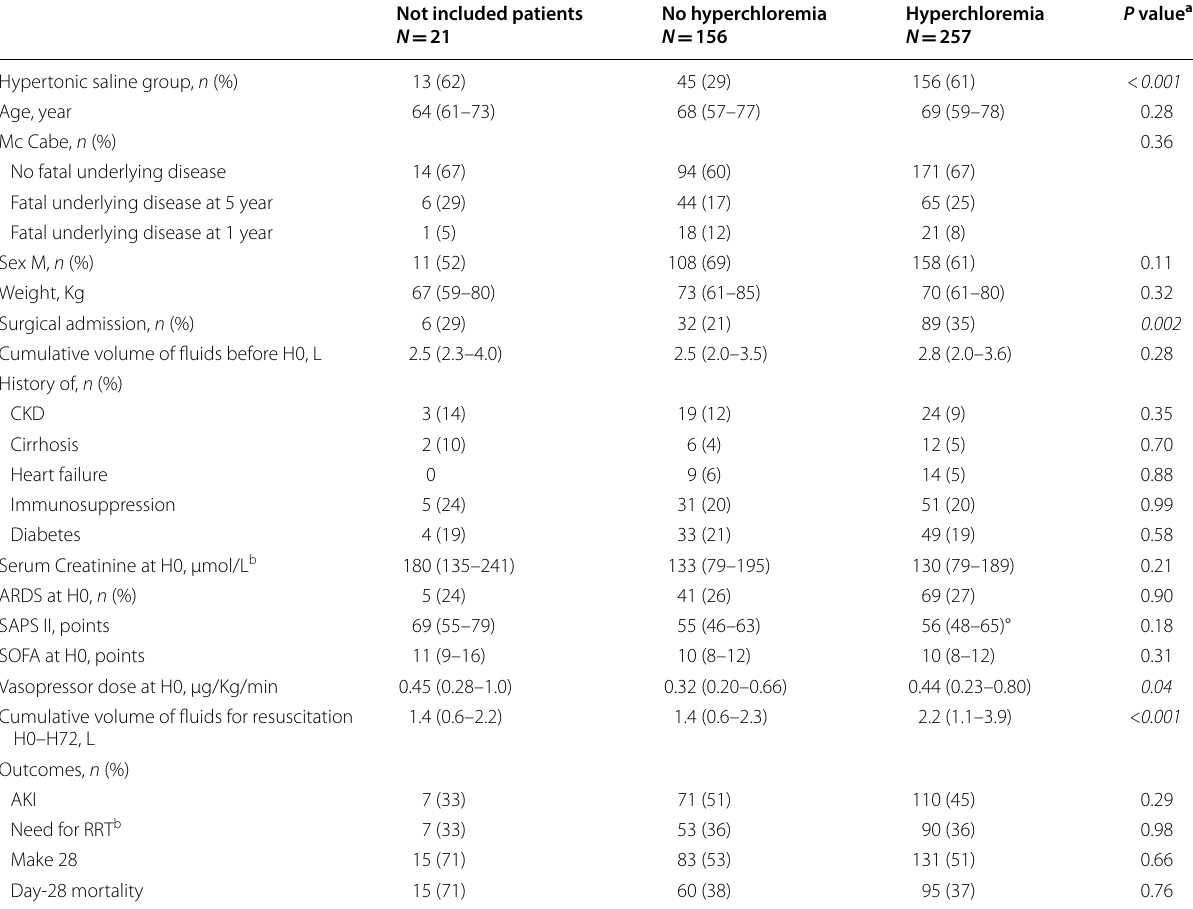
Table 1 Characteristics and outcomes of patients with and without hyperchloremia